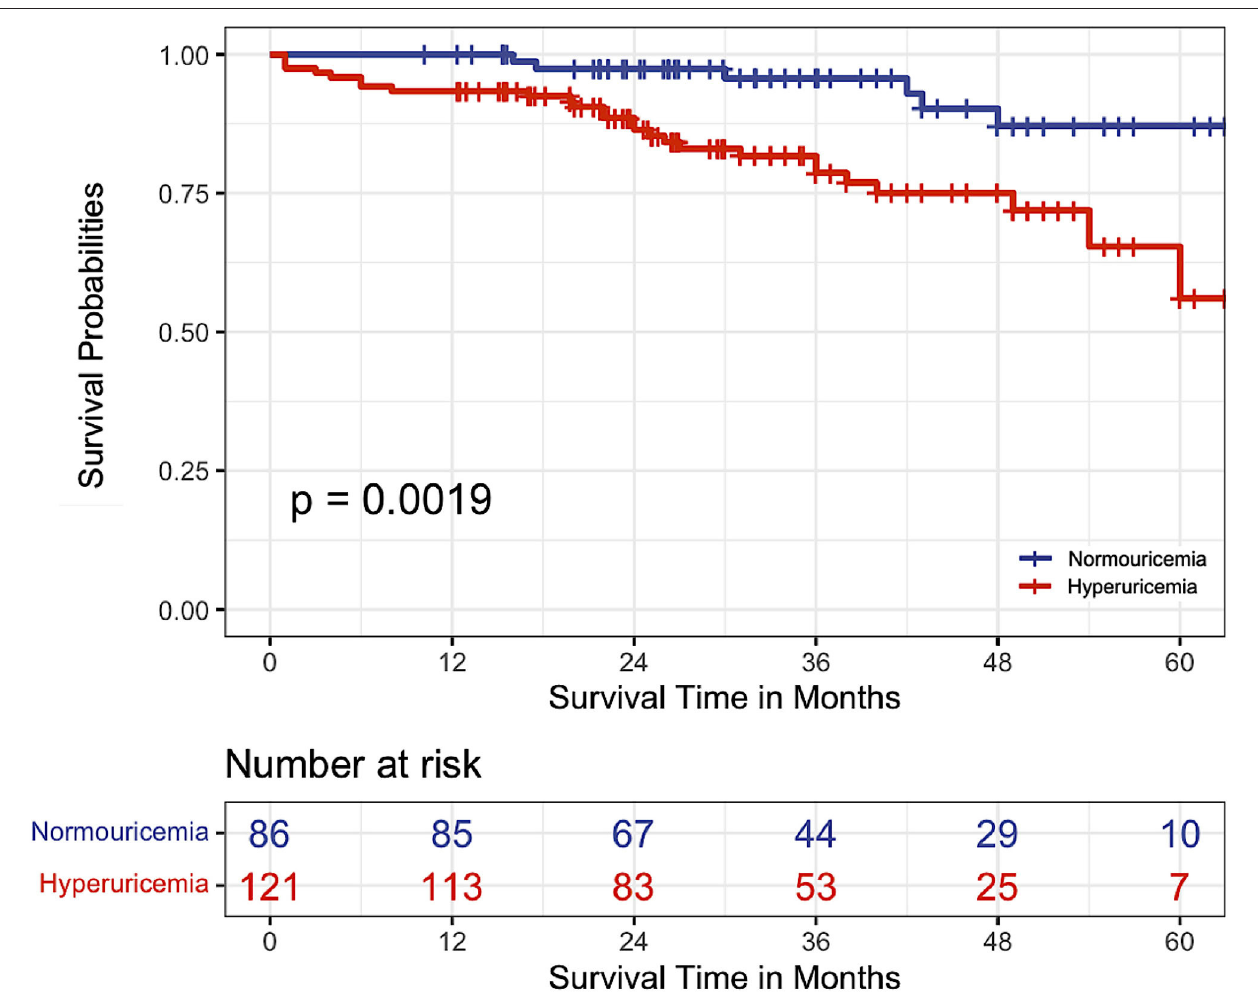
FIGURE 2 | Kaplan-Meier survival curves according to the serum uric acid levels in patients with idiopathic pulmonary artery hypertension.